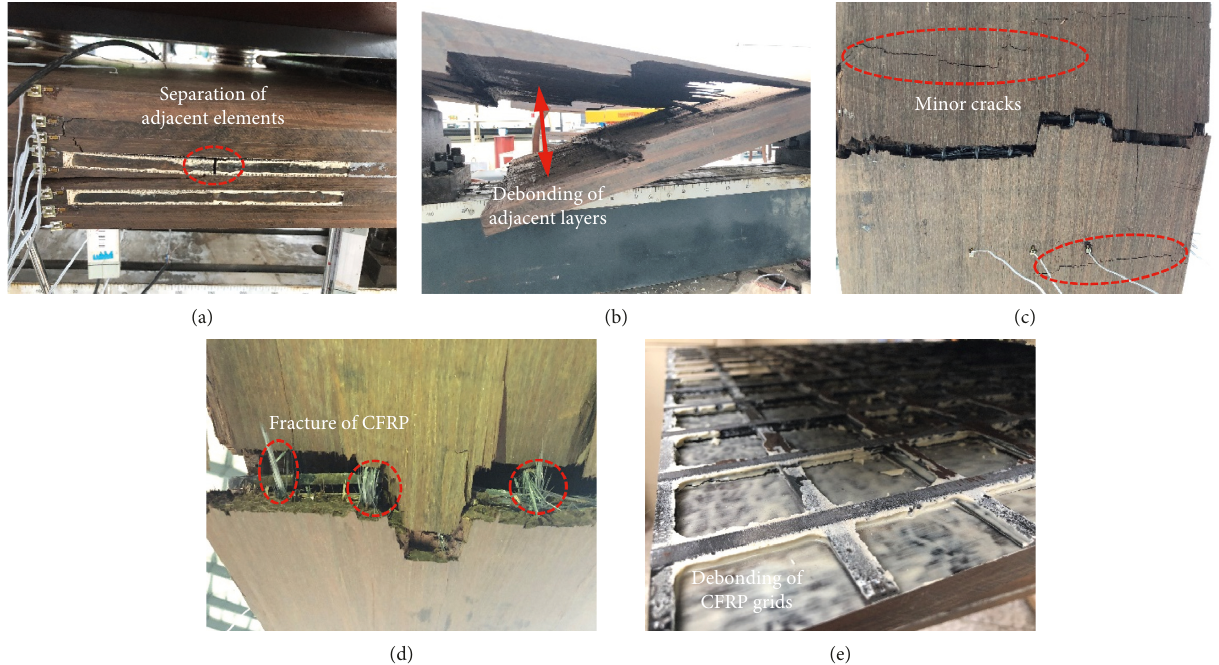
Figure 16: Local drawings of slab specimens. (a) CLB-B4. (b) CLB-C1. (c) CLB-I1. (d) CLB-I4. (e)